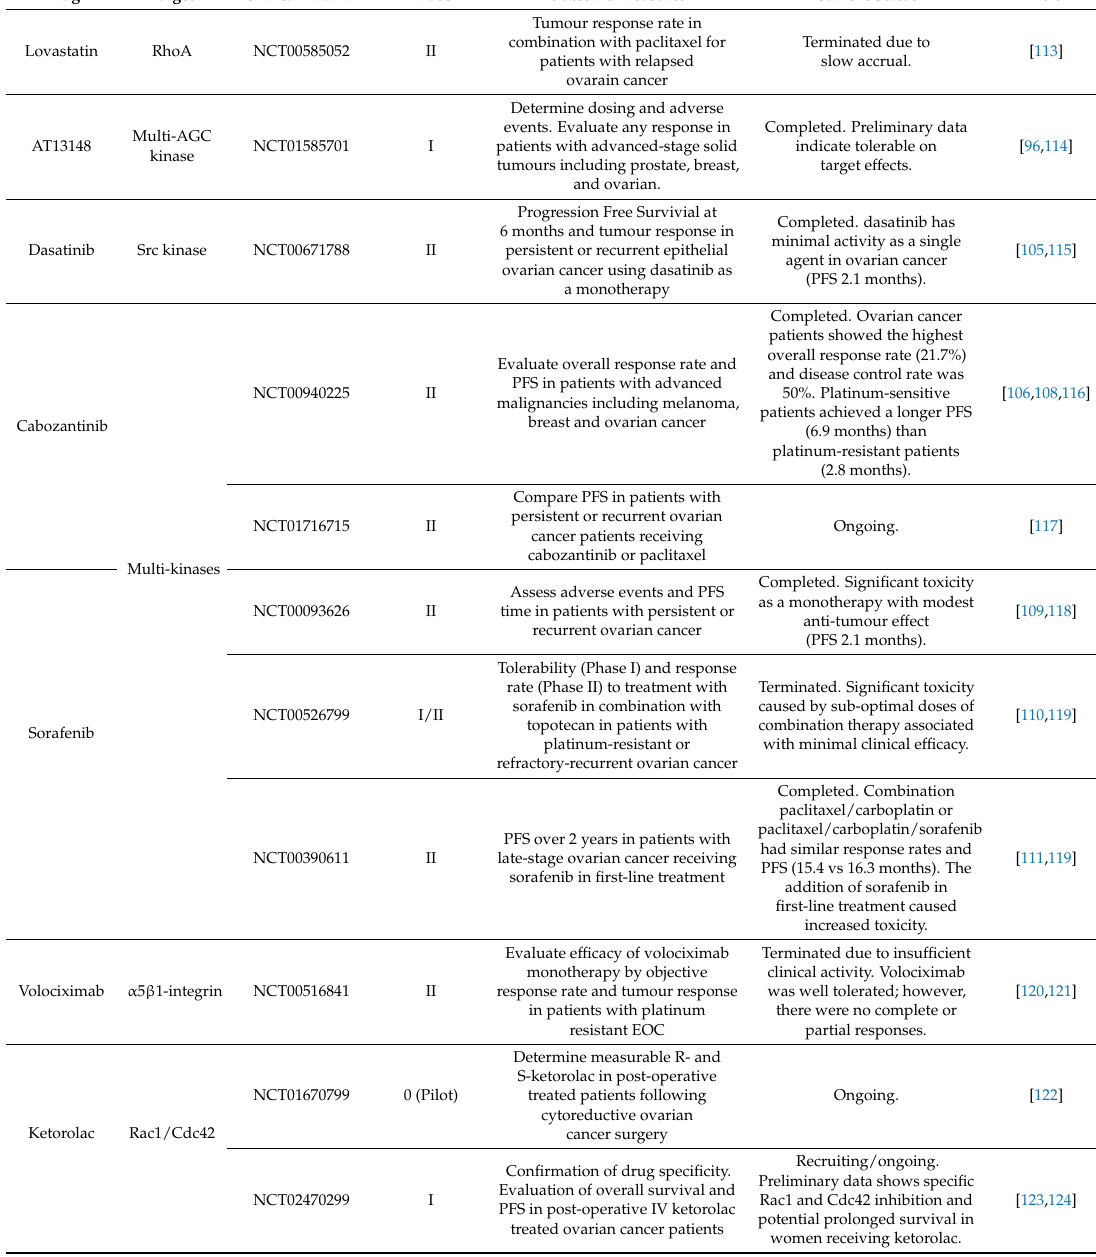
Table 1. Selected targeted drugs in clinical trials for the treatment of metastatic ovarian cancer.